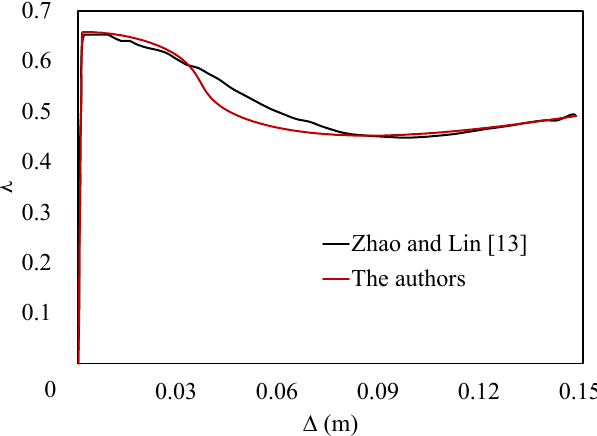
Figure 10. Nonlinear equilibrium paths for the 100,000 m 3 steel tank.